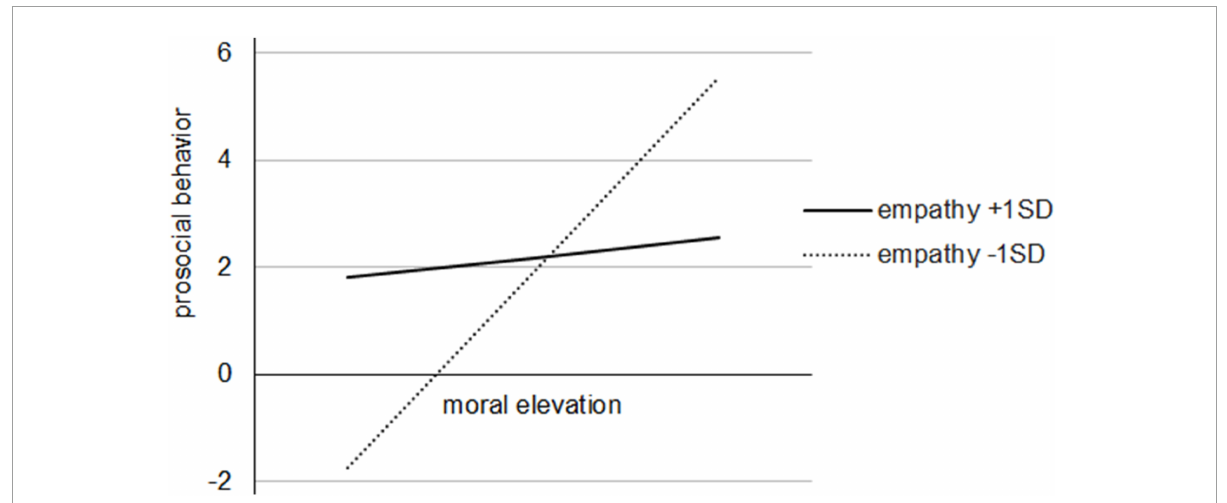
FIGURE2 Plot of interaction of moral elevation and empathy on prosocial